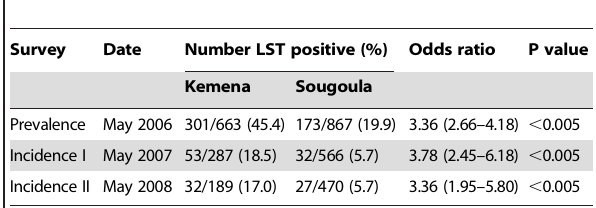
of Leishmania infection was significantly higher in Kemena than